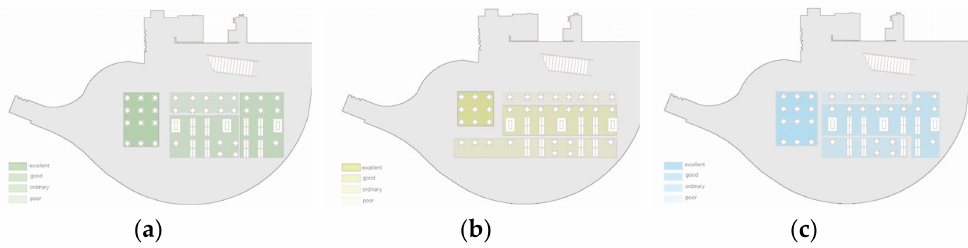
Figure 7. Diagram of seating partitions: ( a ) schematic diagram of green view zoning; ( b ) schematic diagram of man-made view zoning; and ( c ) schematic diagram of sky view